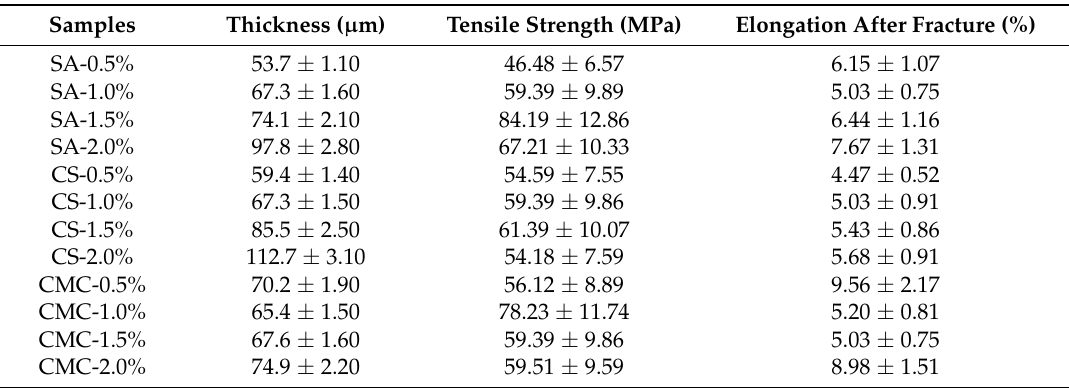
Table 1. The results of complete randomized